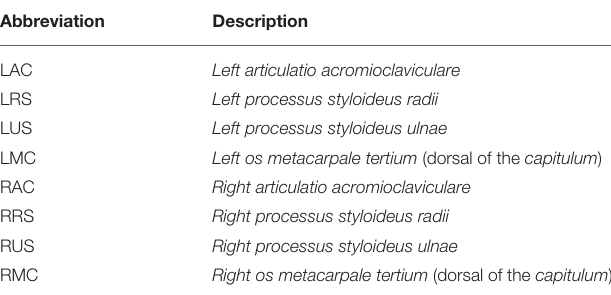
TABLE 2 | Anatomical landmarks used for the kinematic